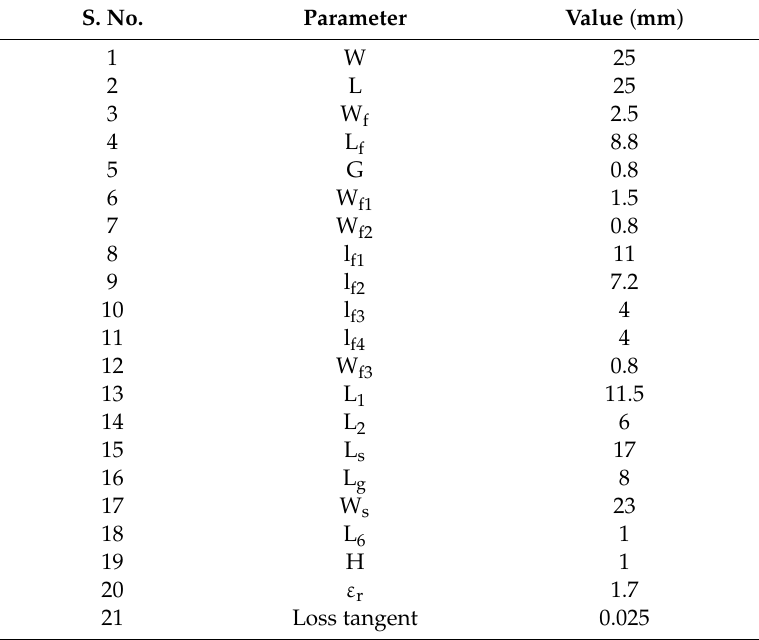
Table 1. Antenna parameters and their